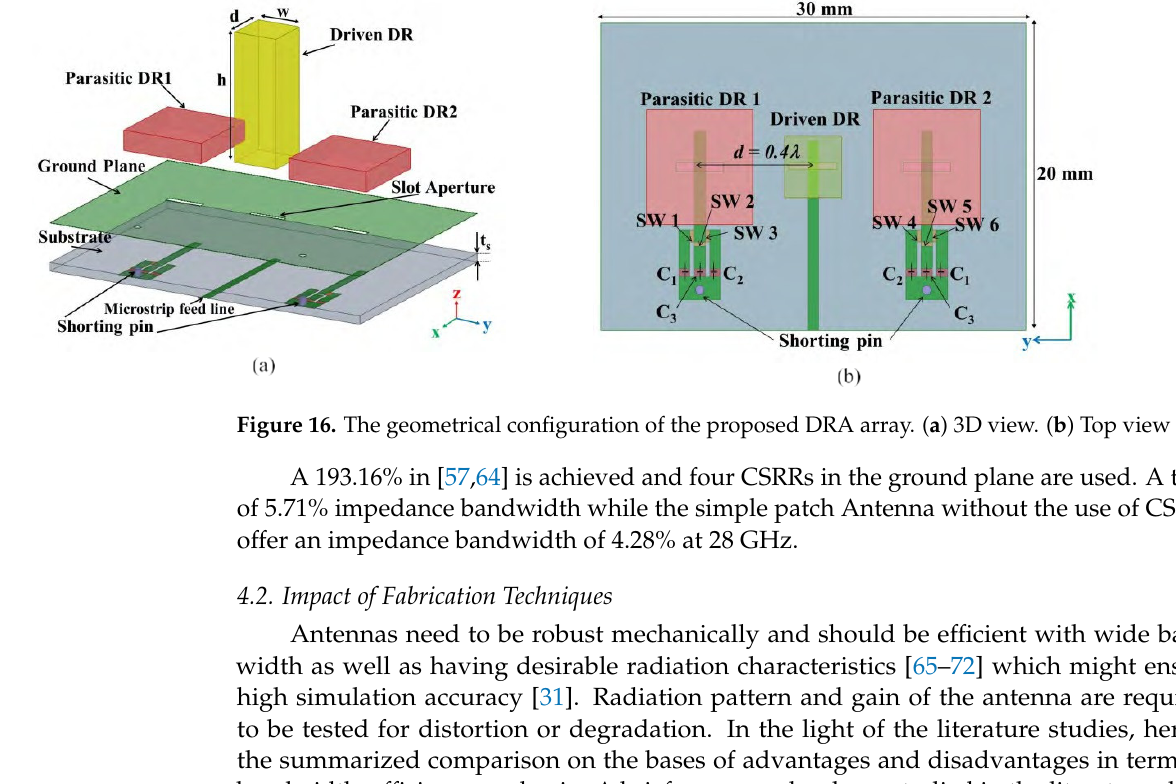
16 of 29 Figure 15. Antenna geometry: ( a , left ) side view ( b , c , left ) top and bottom view, and ( a , b ) ( right ) impact of MS on S 11 and axial ratio [61]. 4. Beam Steerability and Beam Forming 4.1. Dielectric Resonator with Beemsteerability A microstrip patch antenna is presented in this research work. The front and back side of the dielectric slab is arranged periodically to properly adjust the VCRM position. A good radiation pattern is attained with good matching of numerical and experimental results. A high value of 11.9 dB gain is achieved in [62]. A dielectric resonator antenna with parasitic elements is used to achieve high-order mode steerability. The beam steering was successfully achieved by switching the termination capacitor on the parasitic element